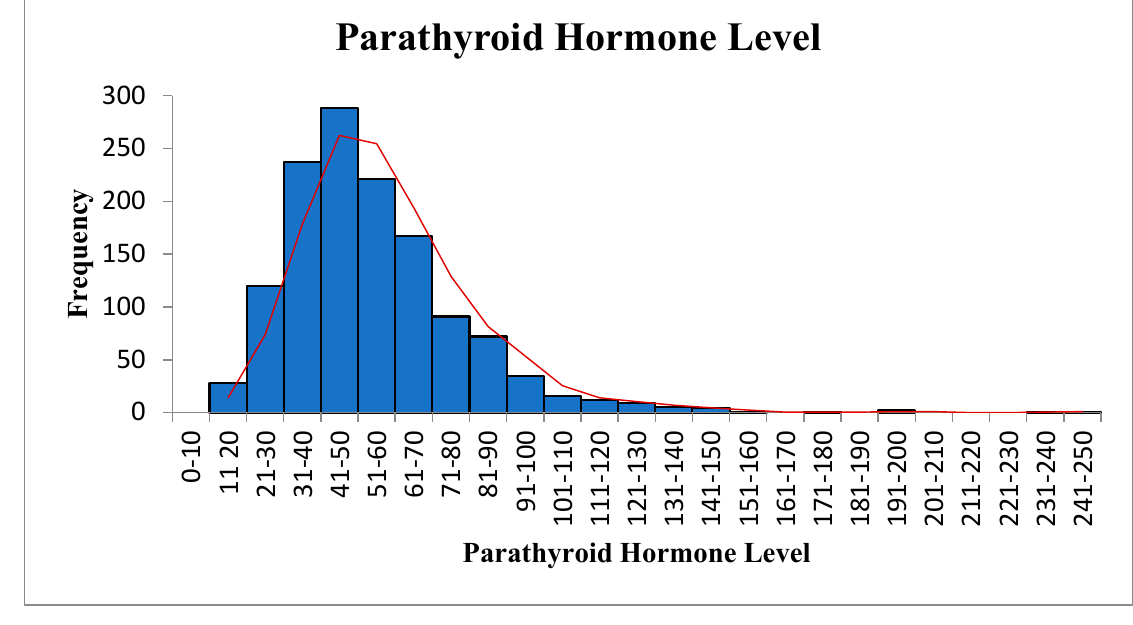
Figure 2. Parathyroid hormone level.